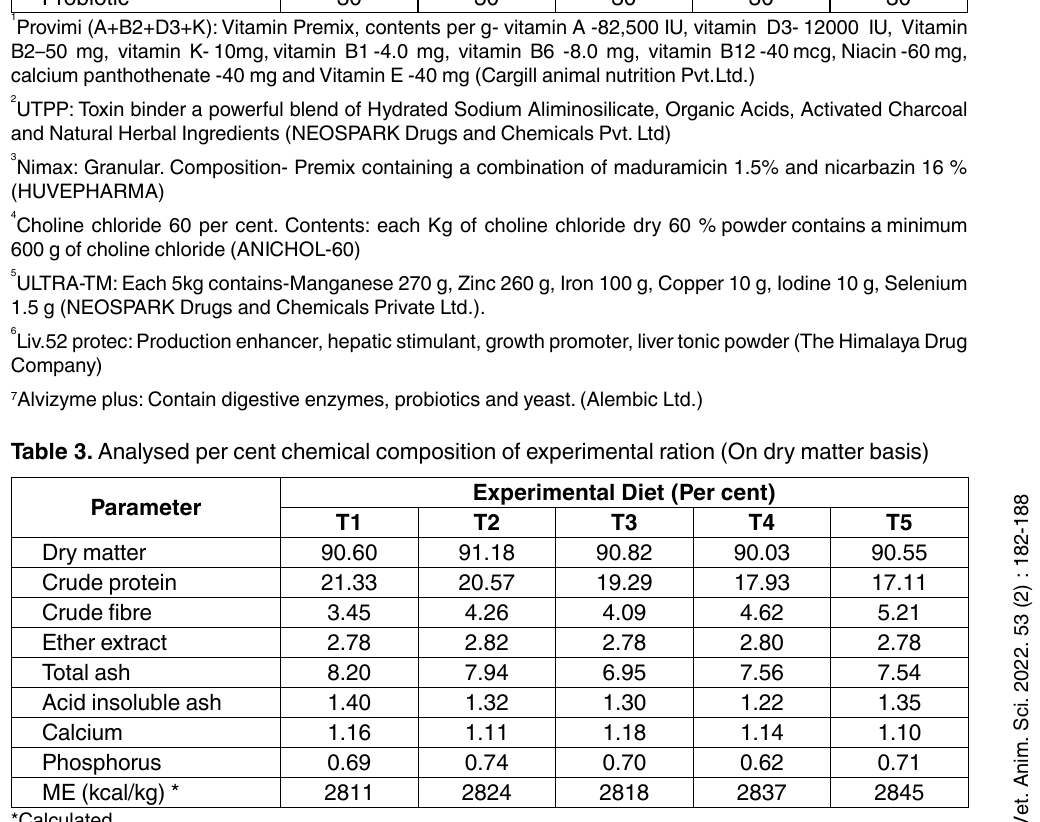
Vitamin AB D K mix 1 3 2 Toxin binder 2 Anticoccidial 3 Choline chloride 60 % 4 150 Trace mineral mixture 5 100 Liver tonic 6 Probiotic 7